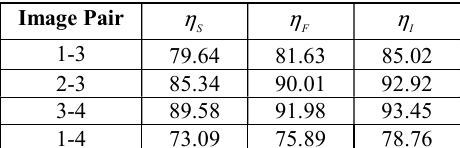
Table 4. Percentage Overlap Values for 90° Corner